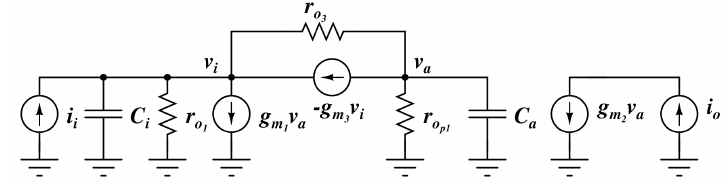
Figure 3. Small-signal model of an FVF cell.